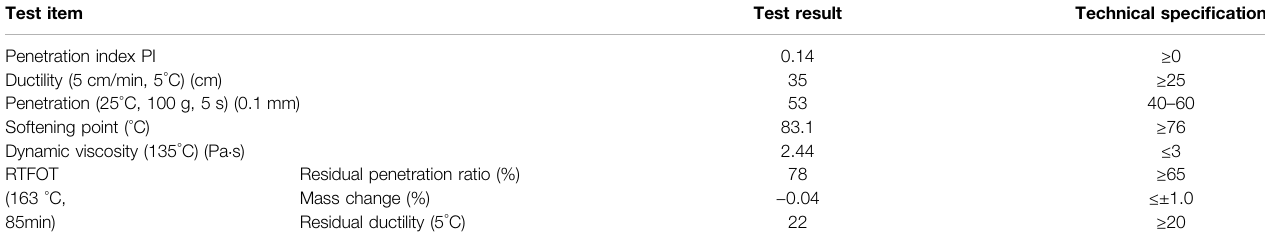
TABLE 1 | Test results of SBS (I-D) modi fi ed asphalt.